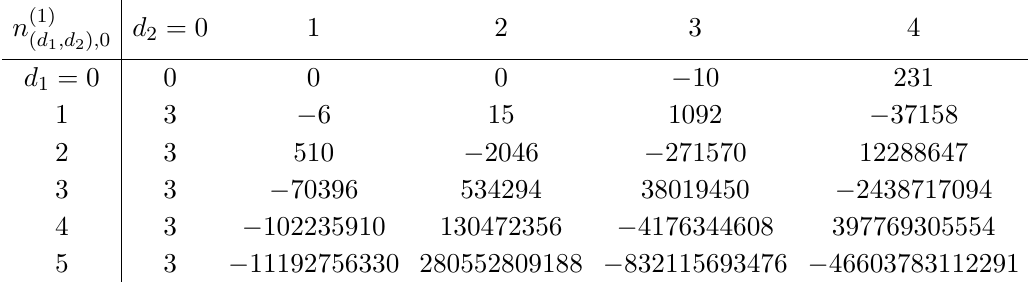
with Z charge 0 . 4 0